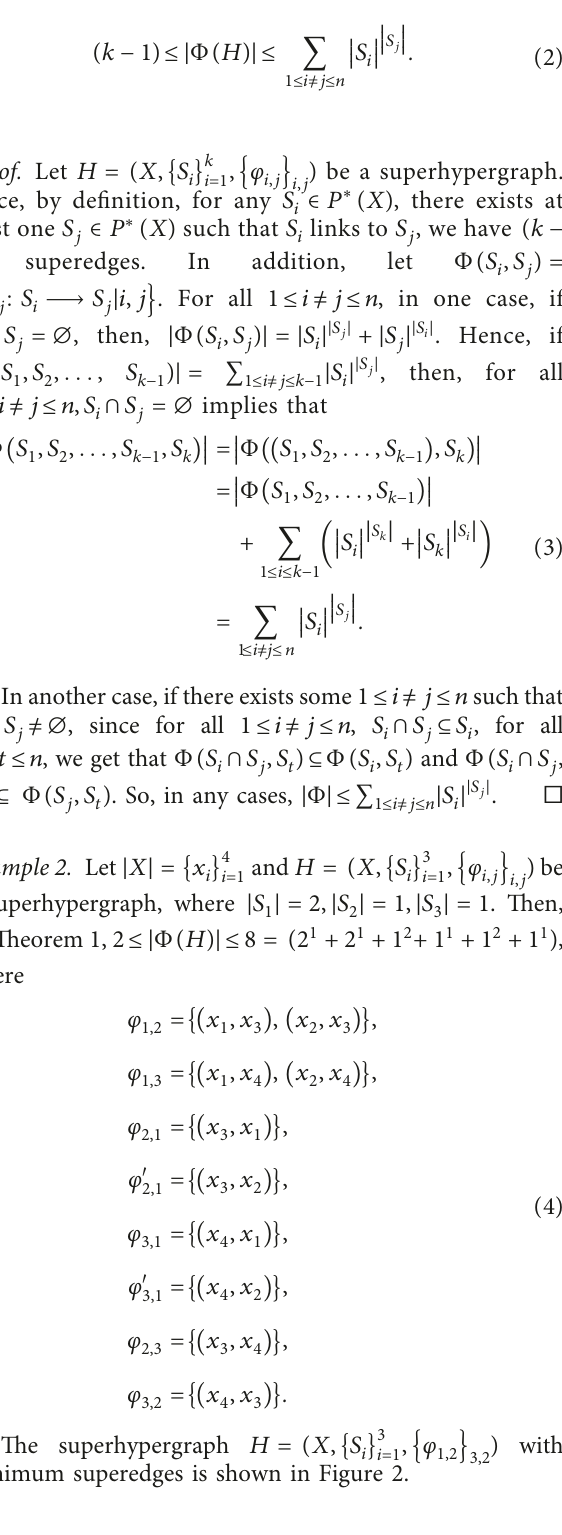
Figure 2: Superhypergraph H � ( X, S | Φ ( H )| �